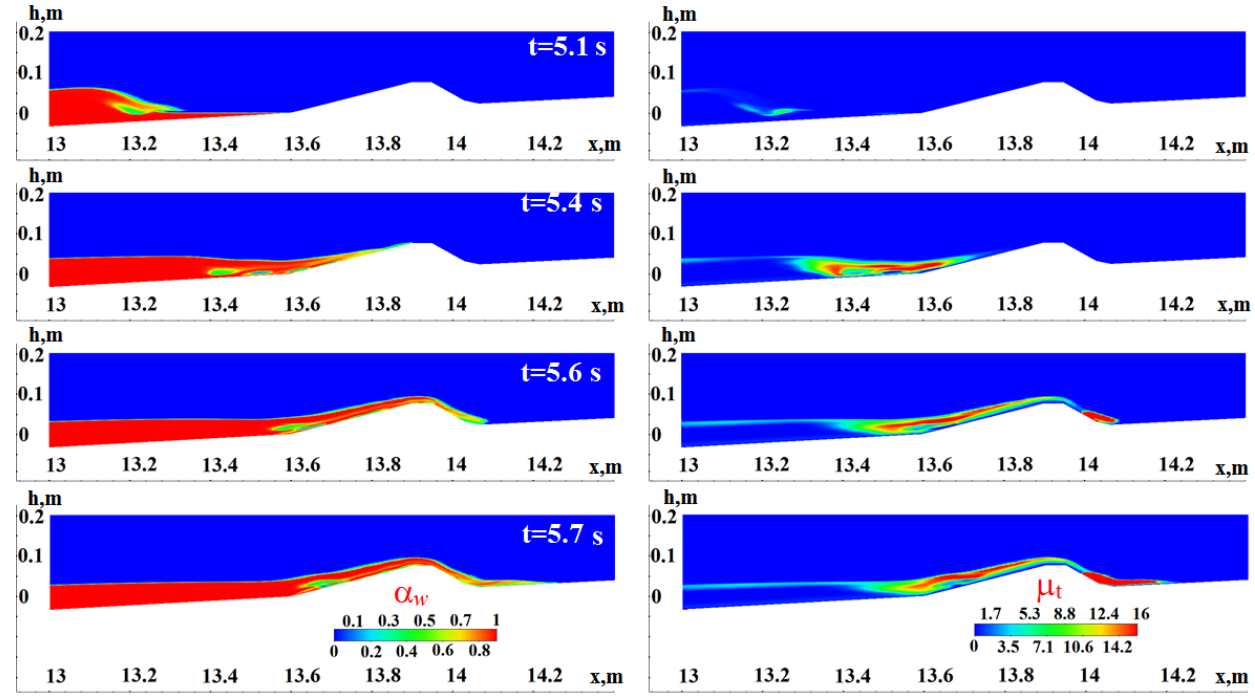
Figure 5. Comparison of the wave profiles for setup 2 ( —without TM, —with TM).